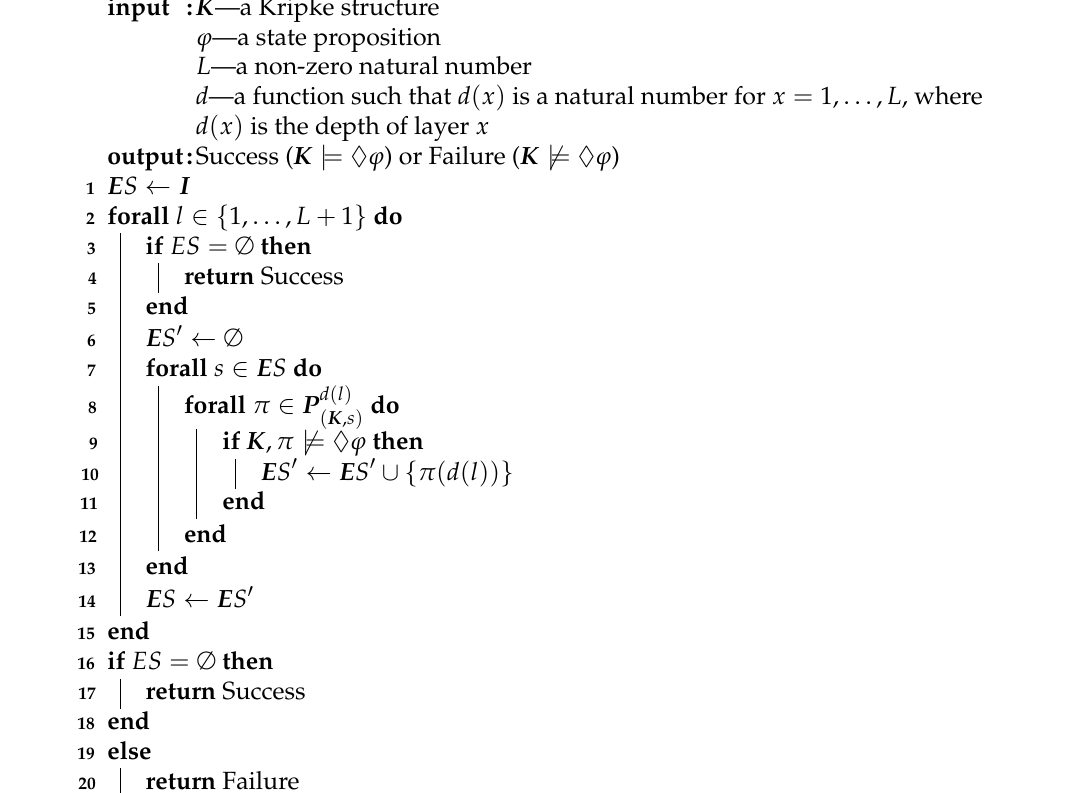
Algorithm 1: A divide and conquer approach to eventual model